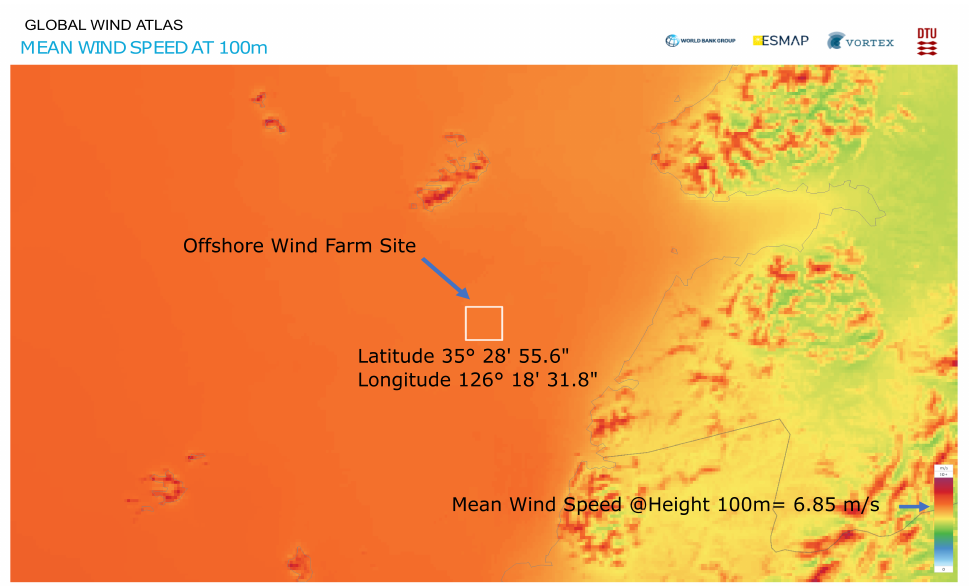
Figure 5. Global Wind Atlas: Mean wind speed at